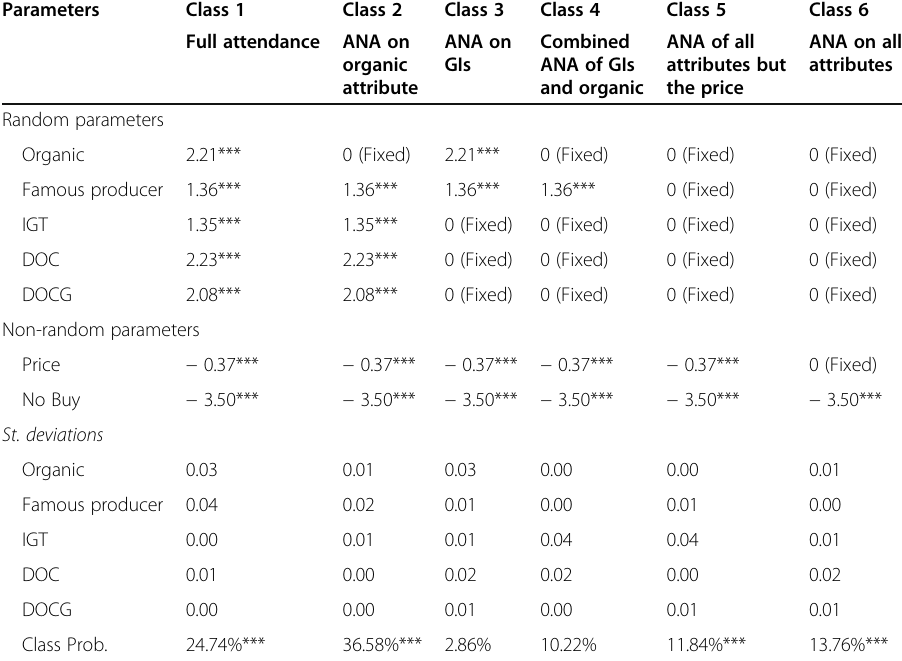
Table 5 Latent class mixed logit model estimates